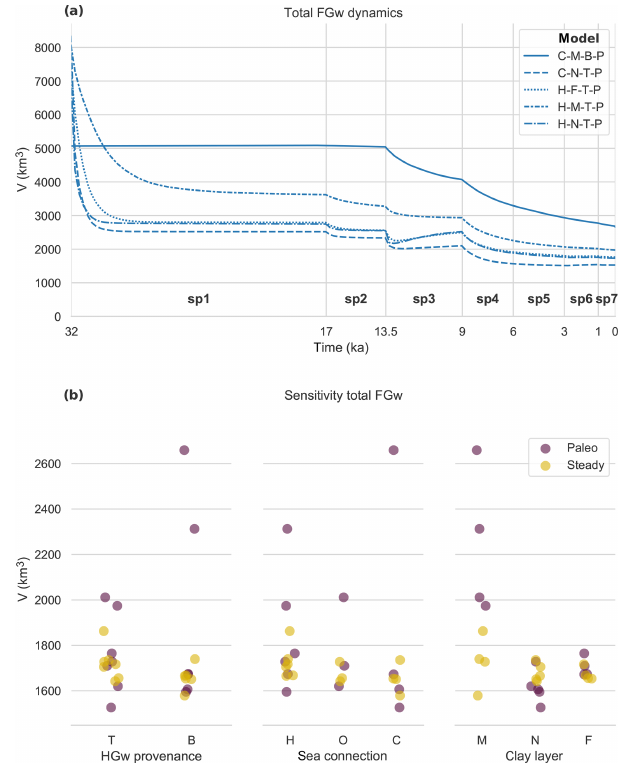
Figure 7. (a) The development of the total FGw volume through time for the five acceptable model scenarios. Stress period numbers are indicated in bold with “sp”. (b) End-state total FGw volumes of all model scenarios, grouped for different inputs. Colours of the dots indicate a steady state or palaeohydrogeological reconstruction result. Dots are jittered to better show overlapping